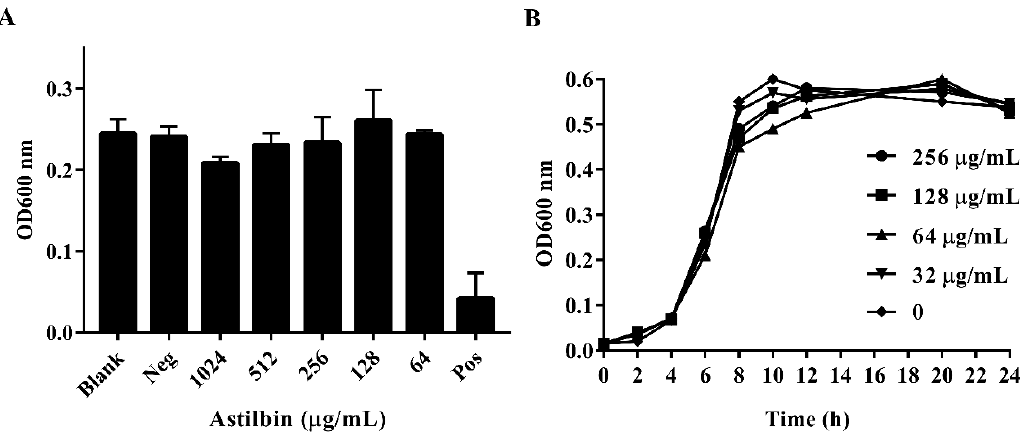
Figure 2. The minimum inhibitory concentration (MIC) of astilbin against S. mutans and the growth curves of S. mutans treated with astilbin. ( A ) The growth state of S. mutans in the presence of different concentrations of astilbin. “Neg” represents the negative control group and “Pos” represents the positive control group. The blank group contained only the brain heart infusion (BHI) broth and the tested S. mutans , the negative control group was treated with 1% dimethyl sulfoxide (DMSO), and the positive control group was treated with 20 μ g/mL of chlorhexidine. ( B ) The growth curves of S. mutans treated with different concentrations of astilbin. The initial inoculum was approximately 1 × 10 6 colony-forming units/mL. The growth rates were measured by determining the optical density (OD) every two hours for one day.